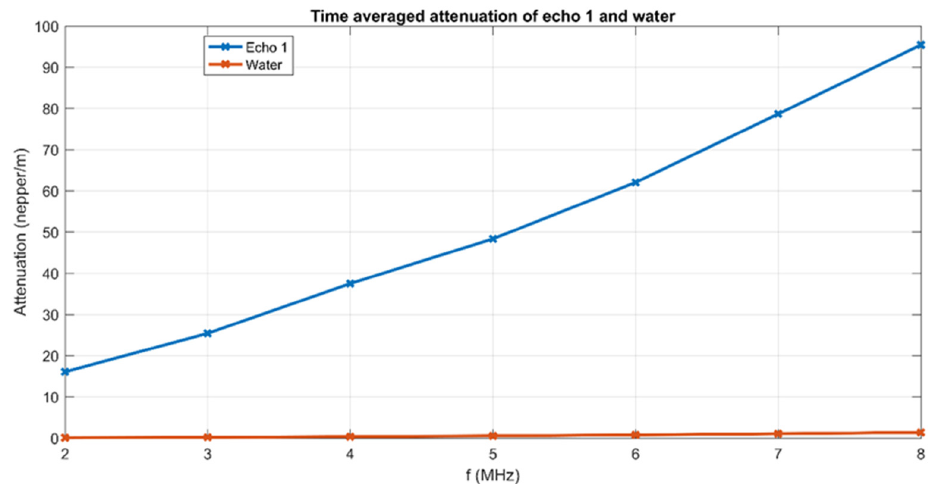
Figure 2. Relative spectral amplitudes of the tested samples.